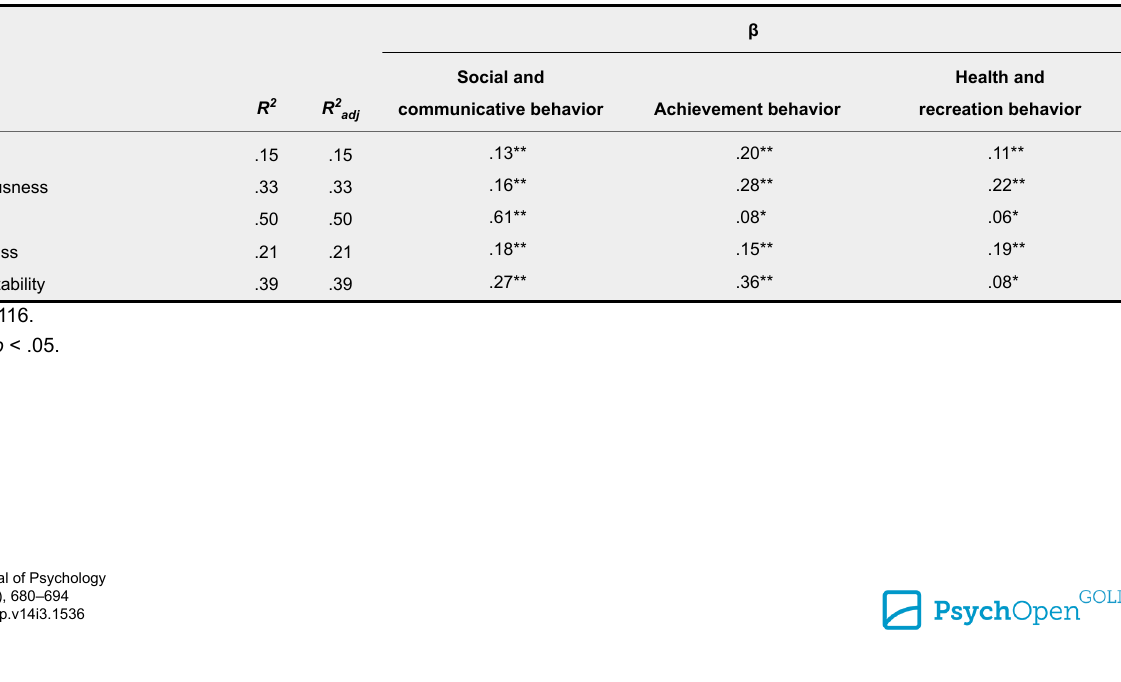
Summary of Regression Analyses of the Big Five on the IPS Domains Construct R 2 R 2 adj Social and communicative behavior .60